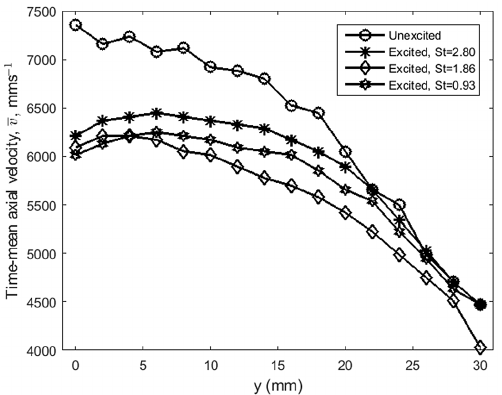
Figure 5. Decay of time-mean axial velocities along the jet cen- terline axis for the case of an unexcited jet and for excited jets at different St